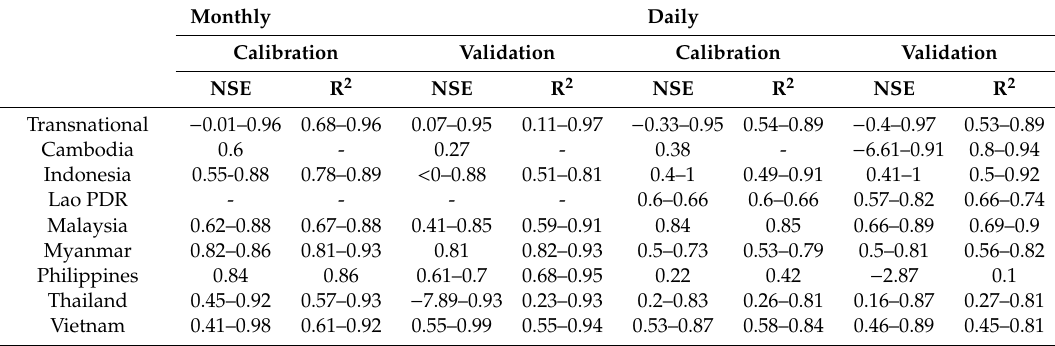
Table 3. The range of statistical values reported for SWAT streamflow calibration and validation by specific Southeast Asia